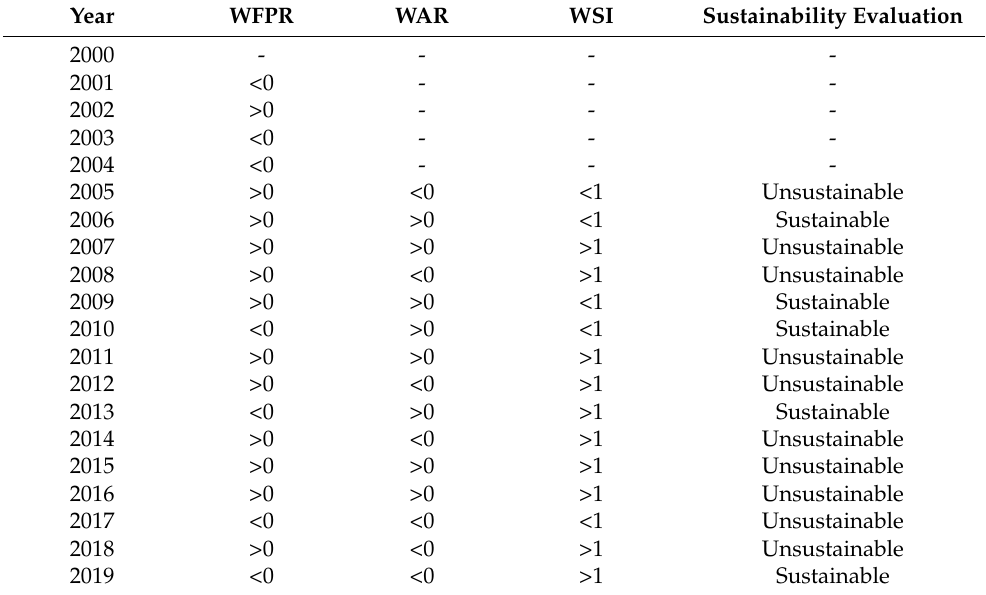
Table 7. Sustainability Evaluation of Water Resources Development in